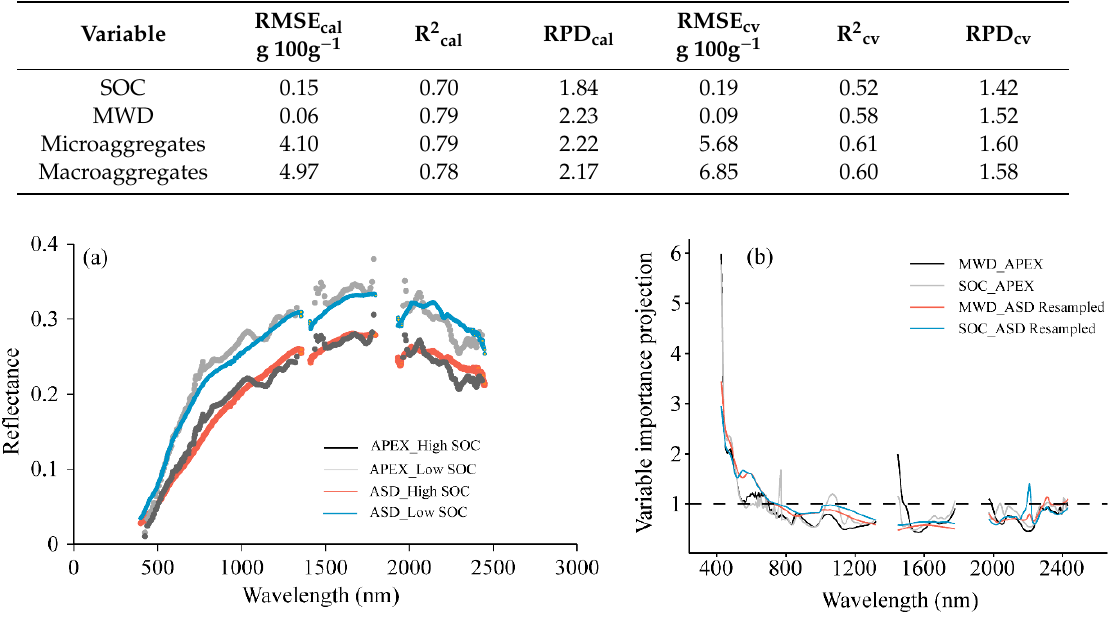
Figure 4. ( a ) Comparison between extracted APEX spectra and field ASD spectra at two locations with distinct SOC contents. ( b ) Variable importance projection (VIP) in partial least squares regression (PLSR) model for MWD and SOC using the extracted APEX spectra. The APEX curves (MWD_APEX and SOC_APEX) were compared to two other independent VIP curves generated using the laboratory ASD spectra (adapted from Shi et al. [29] ), which are resampled to the same spectral resolution as the APEX spectra. Spectral wavelength with VIP value greater than one was considered significant for the PLSR model.